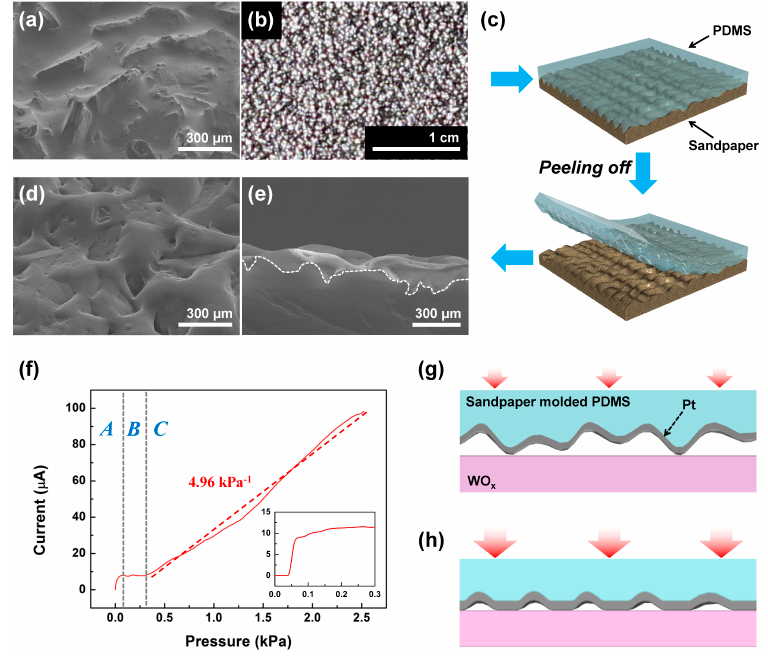
Figure 2. The sandpaper molded PDMS (SMP); ( a ) The SEM image and ( b ) the optical image of a sandpaper with a grit size of 80 (CAMI grit designation); ( c ) the molding process of SMP; ( d ) the oblique angle and ( e ) cross-sectional SEM images of SMP, where the white dashed line shows the cross-sectional boundary; ( f ) the pressure dependent output current of a basic tactile sensor based on the SMP at an applied bias of 10 mV, where the inset shows the expanded output characteristics of another sensor, and the schematic illustrations of SMP tactile sensor in region ( g ) A and ( h ) C in Figure 2f. A basic tactile sensor based on the SMP was fabricated by sputtering 30 nm of Pt on the SMP surface and then placing it on a PET film which has a 80 nm layer of sputtered WO x . Pt was used for